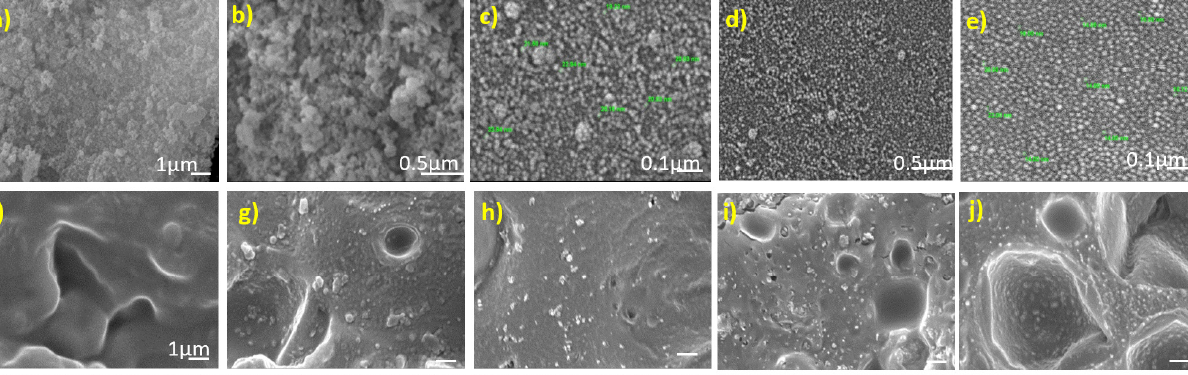
Figure 1. SEM images of pure nHA powder at ( a ) 10,000× magnification, scale bar = 1 μ m; ( b ) 40,000× magnification, scale bar = 0.5 μ m; and ( c ) 20,000× magnification, scale bar = 0.1 μ m. nHA suspended in aqueous solution at ( d ) 0.5 μ m and 50,000× and ( e ) 0.1 μ m and 100,000×. SEM images of PLLA/nHA nanocomposites ( f ) PLLA, ( g ) PLLA/nHA 1 wt%, ( h ) PLLA/nHA 5 wt%, ( i ) PLLA/nHA 10 wt%, and ( j ) PLLA/nHA 20 wt%. SEM images of PLLA/COC10-nHA nanocomposites ( k ) PLLA/COC10, ( l ) PLLA/COC10-nHA 1 wt%, ( m ) PLLA/COC10-nHA 5 wt%, ( n ) PLLA/COC10-nHA 10 wt%, and ( o ) PLLA/COC10-nHA 20 wt%. Nanocomposites. ( f–o ) Scale bar = 1 μ m and the images were taken at 10,000 kV. 3.1.2. Wide-angle XRD of Nanocomposites XRD was carried out for the phase confirmation of the synthesized nHA. The XRD pattern of nHA shown in Figure 2a has characteristic diffraction peaks of HA at 2 θ = 25.8°, 31.9°, 32.9°, 34.0°, and 39.8°, corresponding to crystal planes of HA (002), (211), (300), (202), and (310), respectively. XRD data matched the JCPDS 09-0432 and was in agreement with the already reported data [30]. The crystallite size of synthesized nanoparticles by using the Scherer formula was found to be 22.3 nm. XRD patterns of both PLLA and PLLA/COC10 had PLLA α -phase (unit cell dimen- sions a = 1.06 nm, b = 0.106 nm, and c = 2.88 nm). PLLA α -phase reflects intense peaks at planes (110)/(200) at angle 16.7° and (203)/(113) at angle 19.0° and other planes (011) and (211) reflect at angle 14.6° and 22.3° at angle as shown in Figure 2b [11,31]. On addition of nHA (1–10 wt%) in PLLA/COC10 composites, diffraction peaks of PLLA showed in- creased intensity as compared to the neat PLLA. These results indicated PLLA/COC10- nHA had increased crystallinity as compared to PLLA because of the nucleation effect of nHA and COC for PLLA chains. On further increasing nHA content to 20 wt%, the char- acteristic peak intensity of PLLA started decreasing. Observation of the position of the XRD pattern indicated that the diffraction peaks appeared at intermediate values assigned in the literature to the pure α and α ’ forms of PLLA shown in Figure 2c,d [32]. This revealed an interesting fact about PLLA crystal structure that, on nHA addition, as a tertiary phase in PLLA/COC10 and as a secondary phase in PLLA, the α′ crystal structure started to appear, which existed as a pseudohex- agonal crystalline structure with loose packaging of polymeric chains (PLLA) and slightly bigger unit cell parameters, indicated by the broadening of the peaks and shifting towards lower 2 θ 16.4° and 18.7°. This phenomenon was supported by the reported work of MC Righetti et al. [31]and IGI Athanasoulia et al.[33]. Notably, there was no indication of the